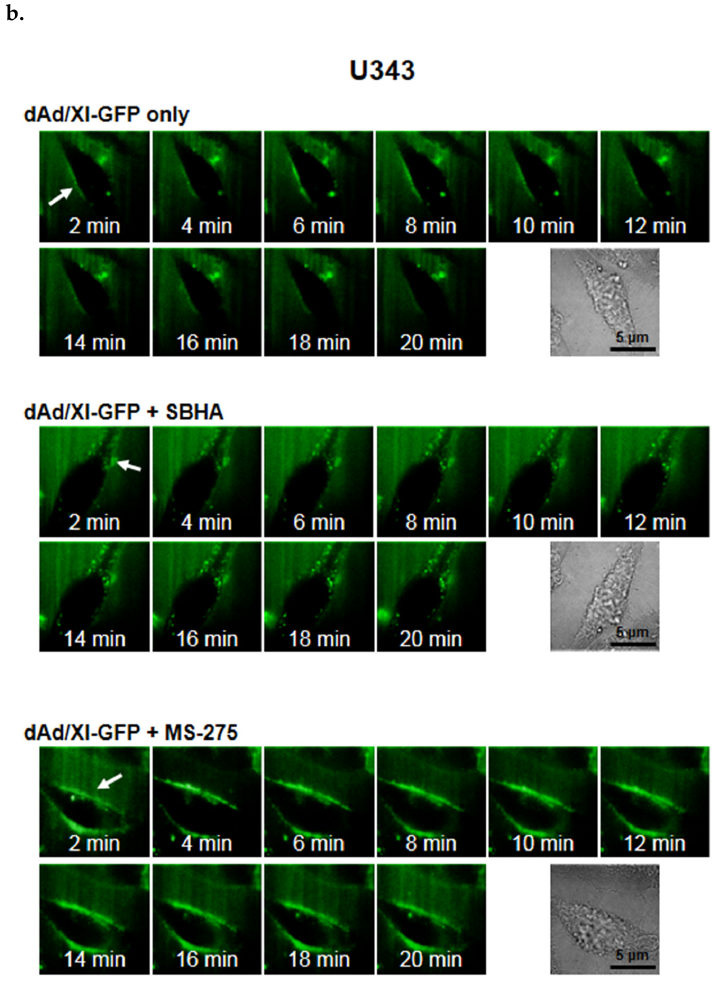
Figure 2. CAR expression level and plasma membrane binding efficiency of Ad following HDACi treatment: ( a ) U343 and A549 cells were treated with either SBHA (20 µ M) or MS-275 (2 µ M) for 24 h. Cells were analyzed for CAR expression by flow cytometry. The data are representative of three independent experiments performed in triplicate. Bars represent the mean ± SD. * P < 0.05, ** P < 0.01. ( b ) U343 cells were pre-treated with SBHA, MS-275, or PBS for 24 h then treated with dAd/IX-GFP. Right after transduction, total internal reflection fluorescence (TIRF) microscope